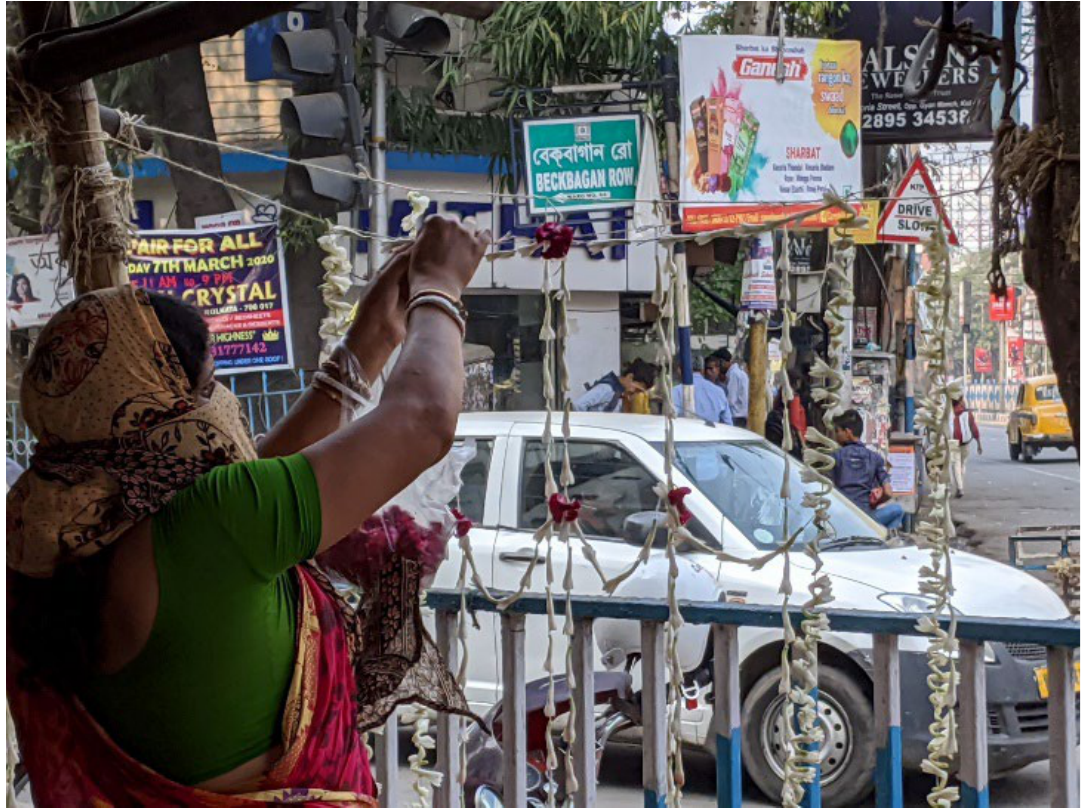
Figure 1 . A flower seller on a street corner covers her face to protect herself from ambient air pollution in pre-COVID-19 Kolkata. Photo by the author, 15 March